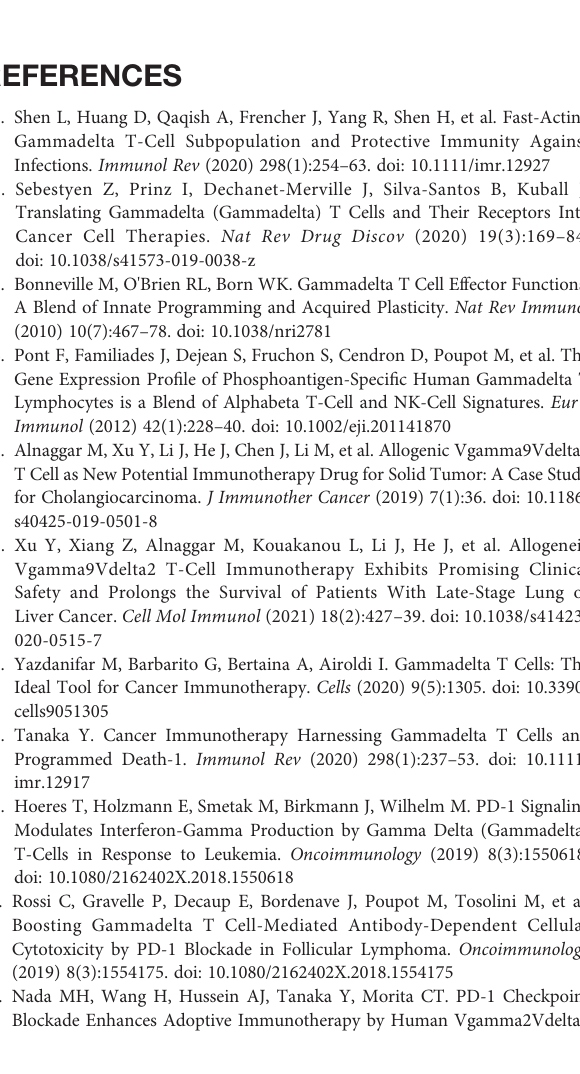
Supplementary Figure 3 | V g 2 x PD-L1 recruited V g 2V d 2 T cells to form cell-to- cell conjugates with SKOV3 cells, but not with 293T cells. 0.1 M CFSE-labelled V g 2V d 2 T cells were incubated with 0.1 M PKH26-stained SKOV3 cells in the presence of 1 m g/mL (8 nM) V g 2 x Null (Left) or V g 2 x PD-L1 (Right) for 30 minutes,